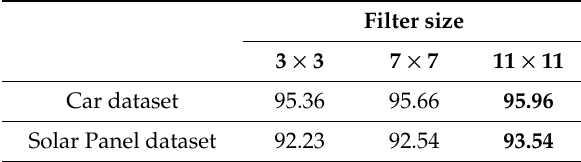
Table 2. Analysis of filter size versus accuracy in primary caps layer (in %): Left: Car dataset, Right: Solar Panel dataset.